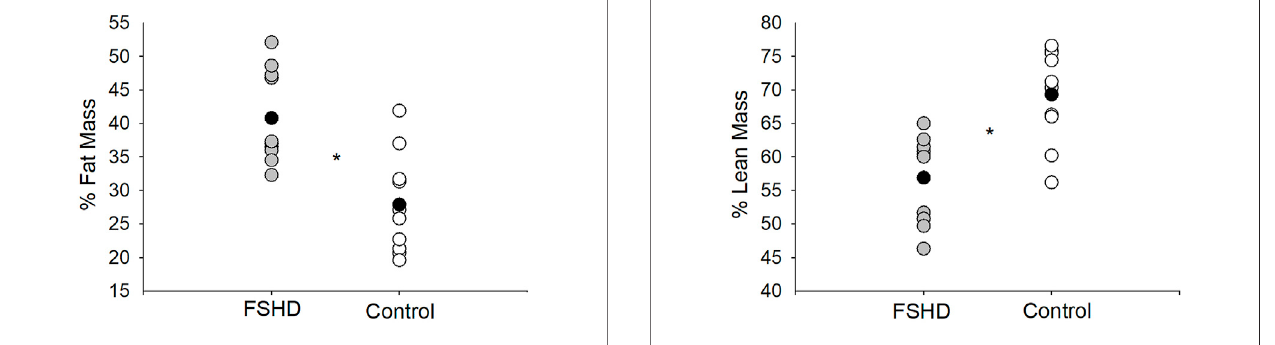
FIGURE 2 | % fat mass in FSHD and controls. Individuals with FSHD had a higher % fat mass, as compared to controls. Black circles indicate average data for each group. * p < 0.01.